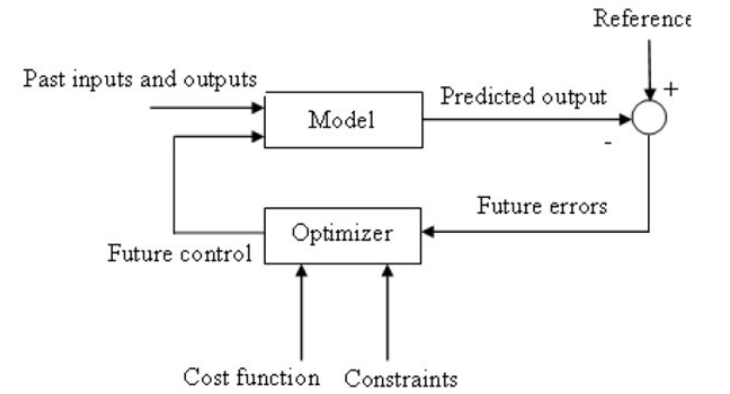
Figure 3. A block diagram describing MPC.